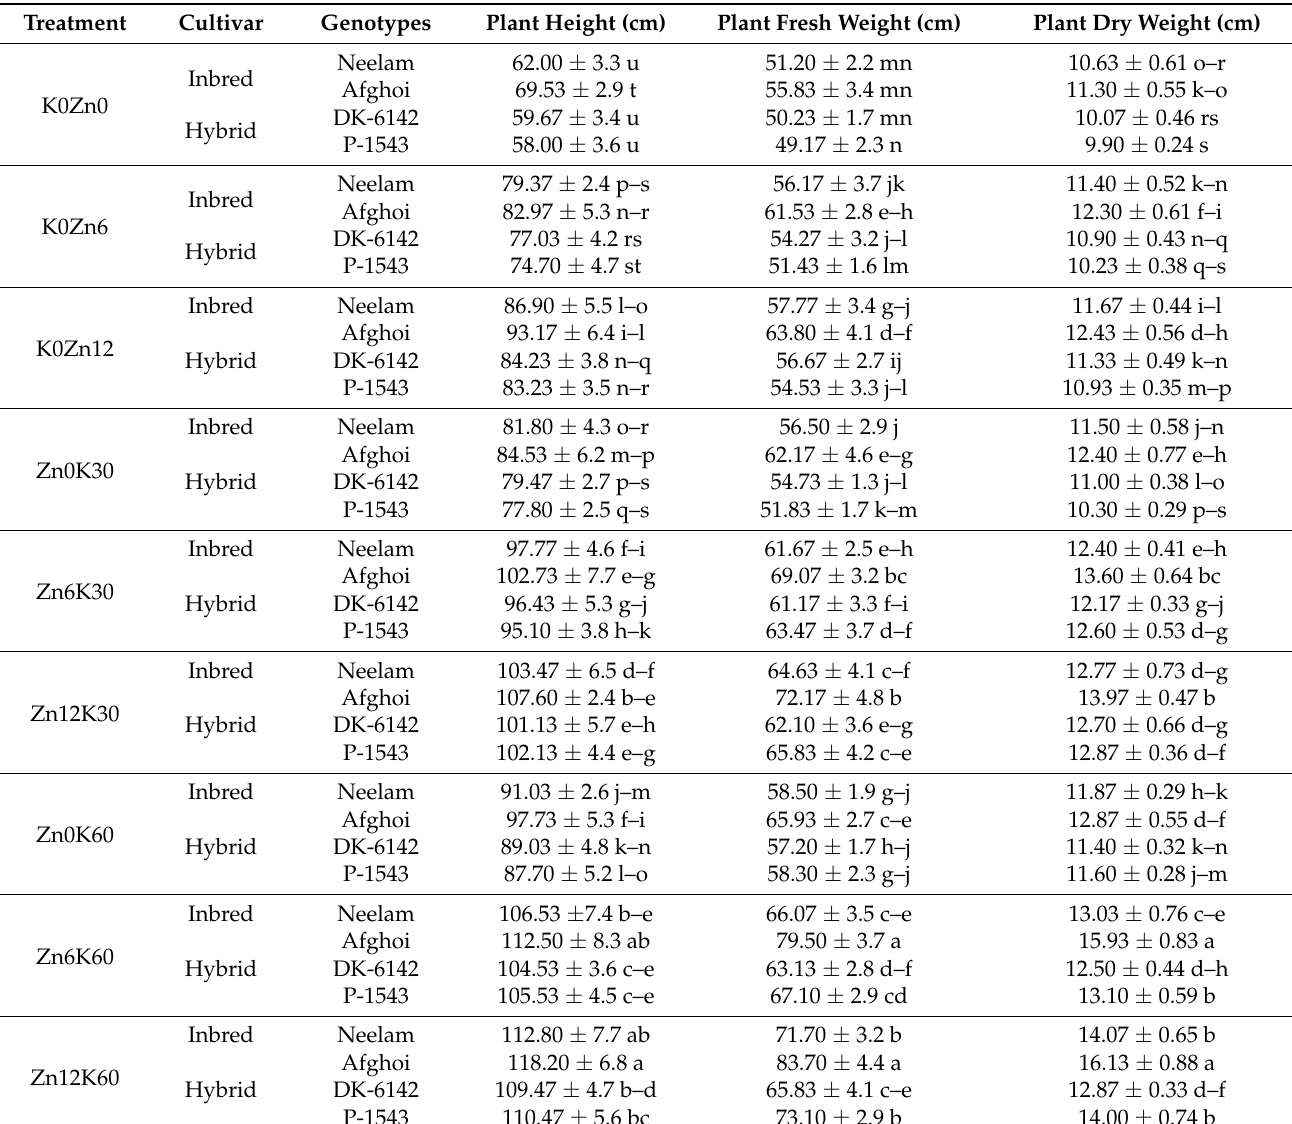
Table 1. Effect of K and Zn on biometric